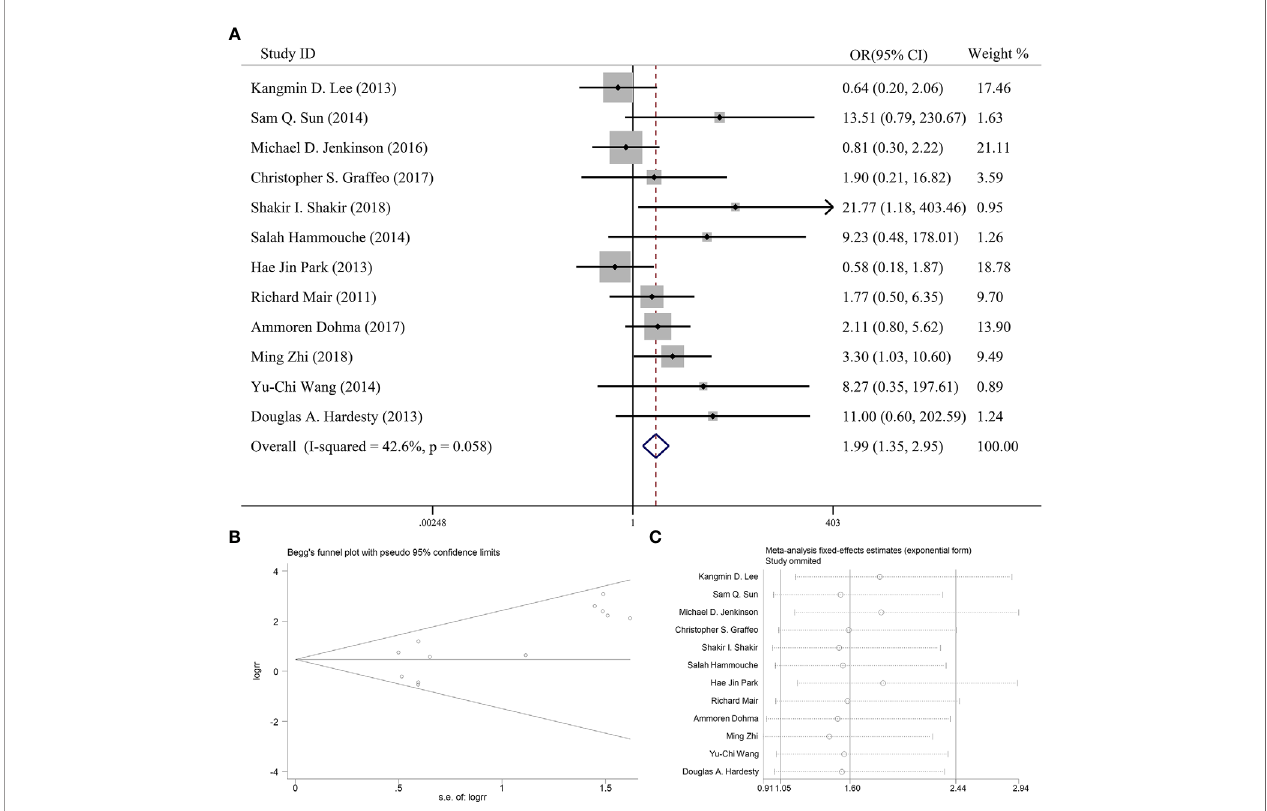
FIGURE 2 | (A) Forest plot for the relationships between PORT and 5-year PFS. (B) Begg ’ s funnel plots of publication bias for meta-analysis of PORT. (C) Sensitivity analysis for meta-analysis of